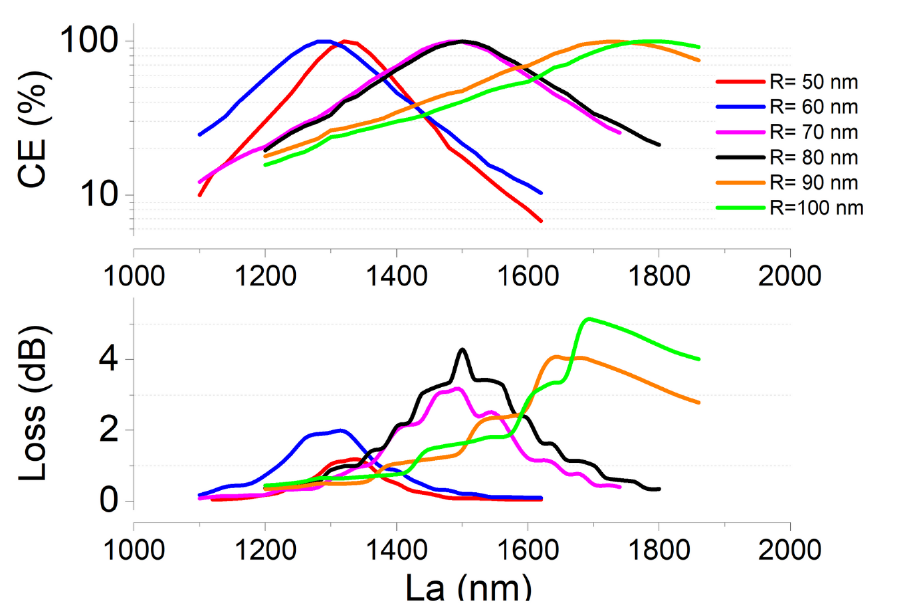
Figure 4. Top panel: CE calculated as a function of the NW radius. The number of NWs is assumed to be the minimum to achieve the maximum conversion. Note that the scale is not linear. Bottom panel: associated total losses calculated as the ratio between the output power and the input power levels.